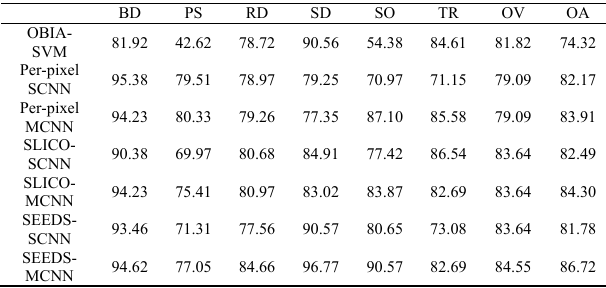
Table 1. Classification accuracy (In percentage) comparison of Urban scene (BD: Building, PS: Parking space, RD: Road, SD: Shadow, SO: Soil, TR: Tree, OV: Other vegetation, OA: Overall accuracy)